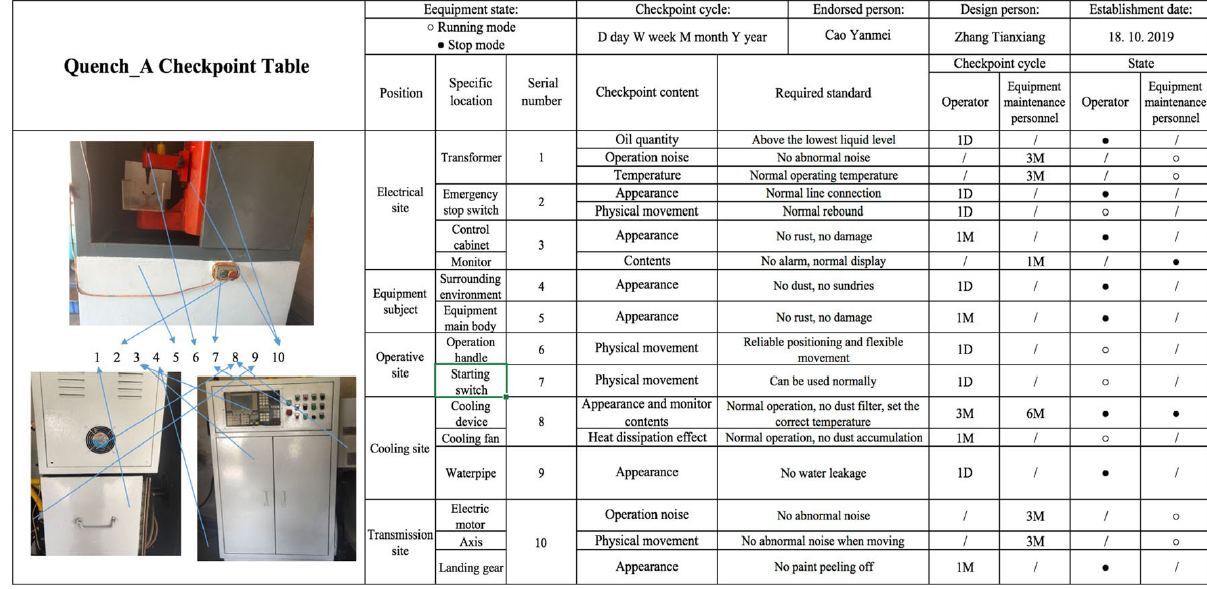
Figure 8. Checkpoint table for Quench_A (The actual display is in